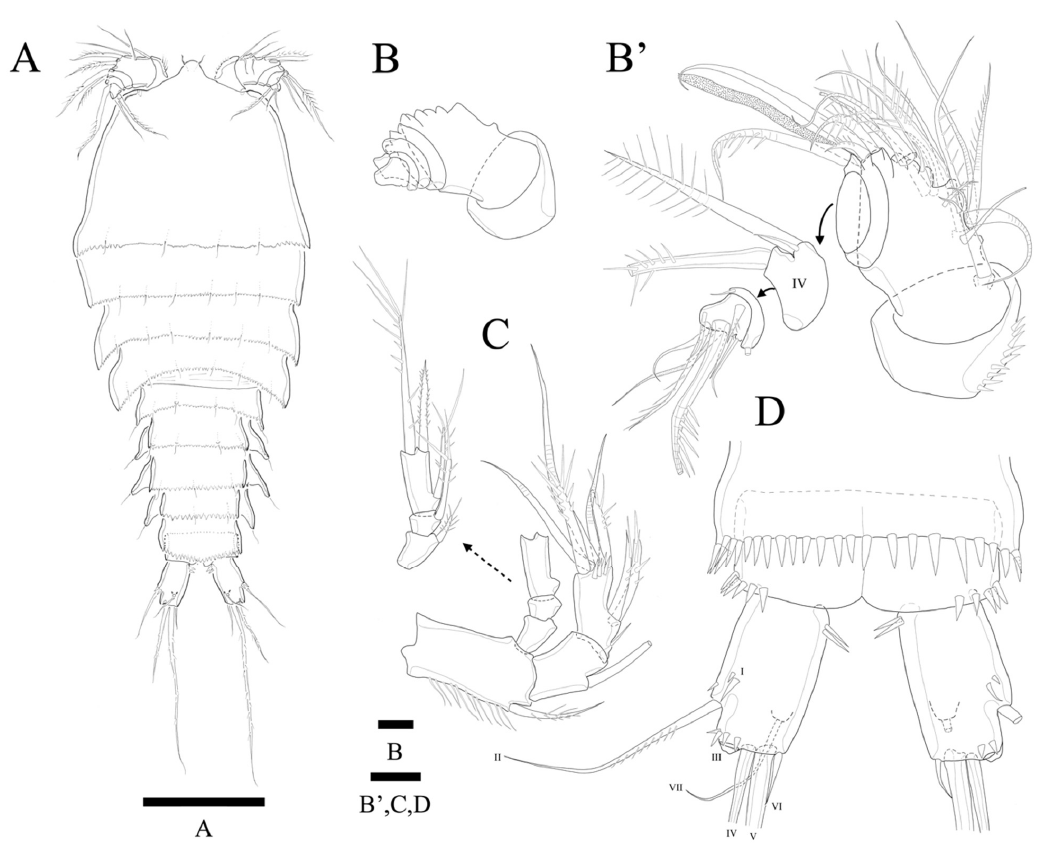
Figure 9. Zosime tunnelli sp. nov. ( A ) Habitus, dorsal; ( B ) A1 showing segmentation, armature omitted ( B’ ) A1; ( C ) A2; ( D ) Anal somite and caudal rami. Scale bars: ( A ) 100 µm; ( B , B’ – D ) 10 µm. Differential Diagnosis . Based on female. Body slightly flattened. Prosome 1.4 times longer than urosome, and distinctly wider than urosome Rostrum bell-shaped, and smoothly round apically. Antennule six-segmented. Genital somite and succeeding uro- somal segments with lateral expansions. Caudal rami 1.4 times longer than anal somite, and 1.5 times longer than wide. P5 with nine setae, without seta on exp surface. Description of Female . Total body length of holotype 452 µm (measured from anterior margin of rostrum to posterior margin of caudal rami). Largest width (223 µm) measured at posterior margin of cephalic shield (Figure 9A). Body slightly flattened. Prosome 1.4 times longer than urosome, and distinctly wider than urosome. Cephalothorax 1.3 times shorter than length, with serrate posterior margin; dorsal surface smooth with few sensilla posteriorly. Prosomites (Figure 9A) with smooth dorsal surface, serrated posterior margins and few sensilla posteriorly as figured.